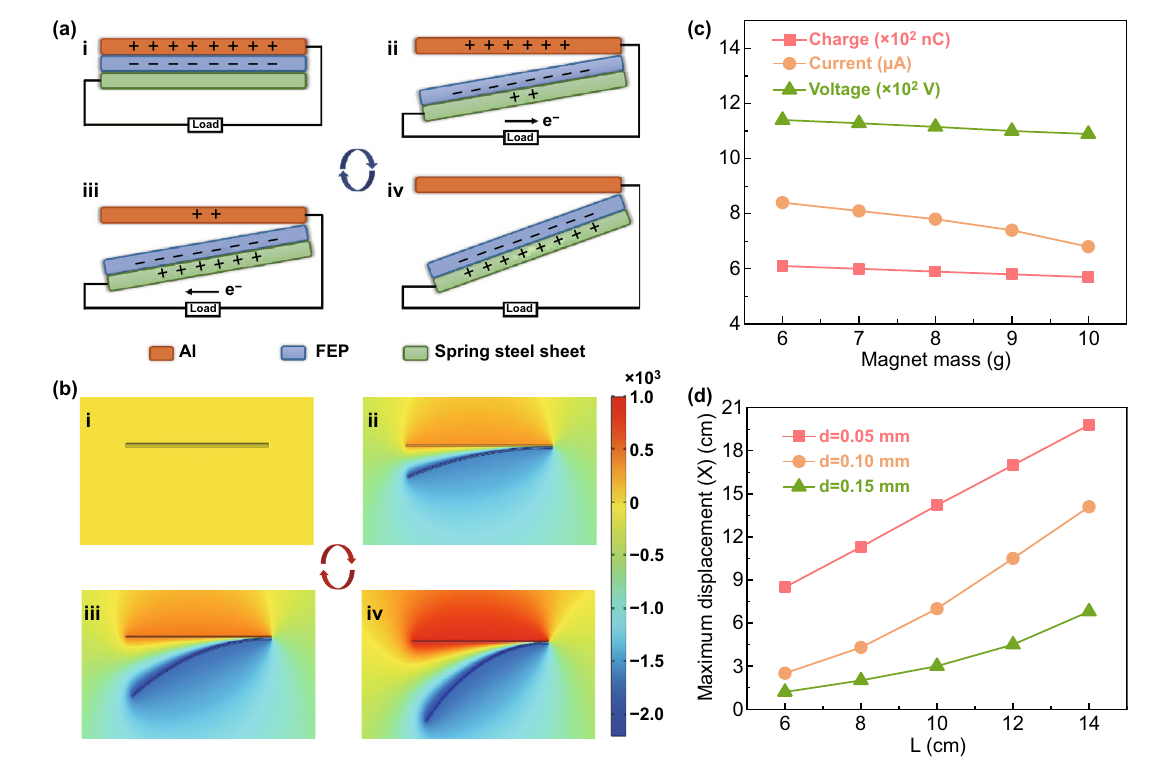
Fig. 2 a Working mechanism of the W-HNG. b Potential distribution across the W-HNG electrodes under open-circuit conditions at different angles states, as evaluated by COMSOL. c Q sc , I sc , and V oc signals under diverse magnet mass. d Varied maximum displacement between FEP and Al on changing both the thickness and length of the spring steel